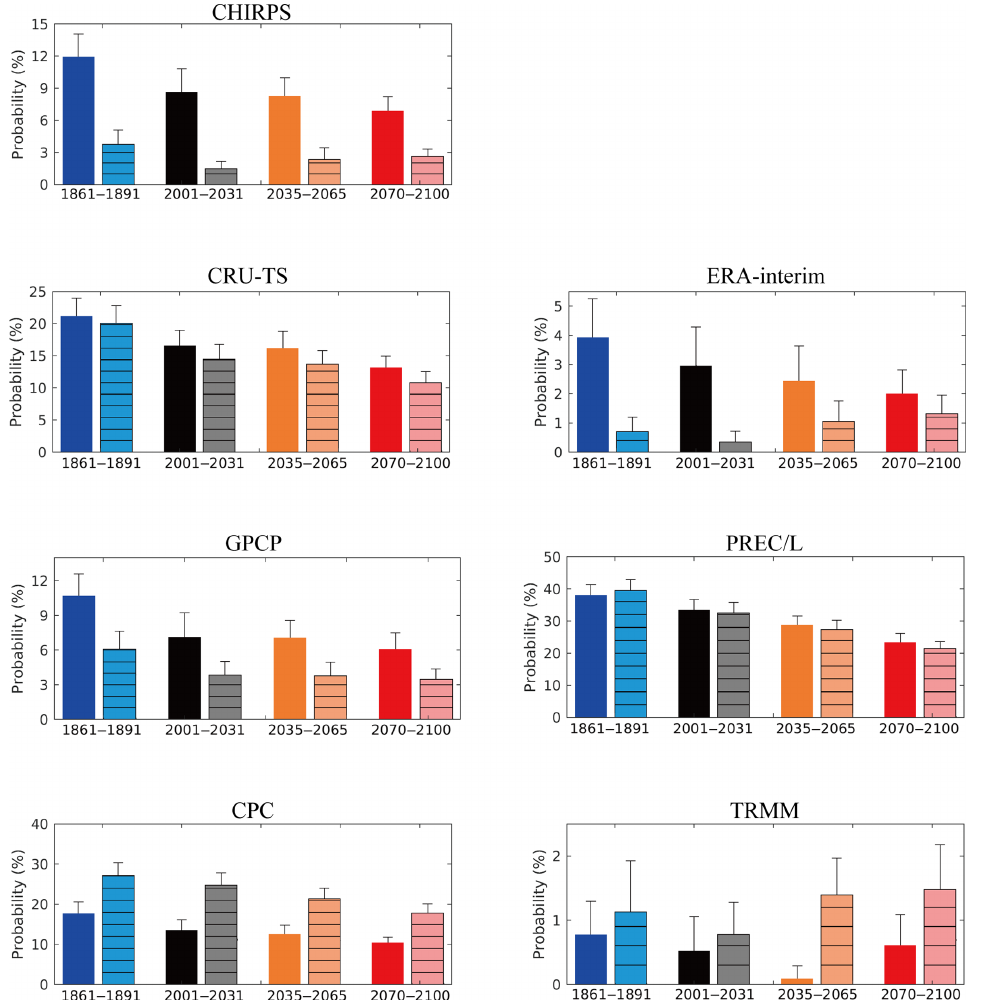
Figure 2. CMIP5 GCM-based histograms of probabilities of mean ASO rainfall falling below year 2016-based threshold values. This is for different time periods and for different observation-based precipitation product of CHIRPS, CRU-TS, ERA-interim, GPCP, PREC/L, CPC and TRMM. Shown for years 1861–1891 (blue), 2001–2031 (black), 2035–2065 (orange) and 2070–2100 (red), and using GCM simula- tions corresponding to historical and RCP8.5 estimates. Individual GCM projections are bias-corrected by the (panel-specific) precipitation product. These data are combined to give single overall probabilities across the 37 GCMs sampled. The histogram bars without horizontal hatching (left) are for the mean-corrected GCM precipitation estimates. The bars with hatching (right) are for the mean- and variance- corrected GCM estimates. The error bars are 2SD (estimated via bootstrapping 80% replications from the 37 GCM precipitation data for the 31-year periods). Data in the CHIRPS panels repeat those of the insets of Fig. 1c and